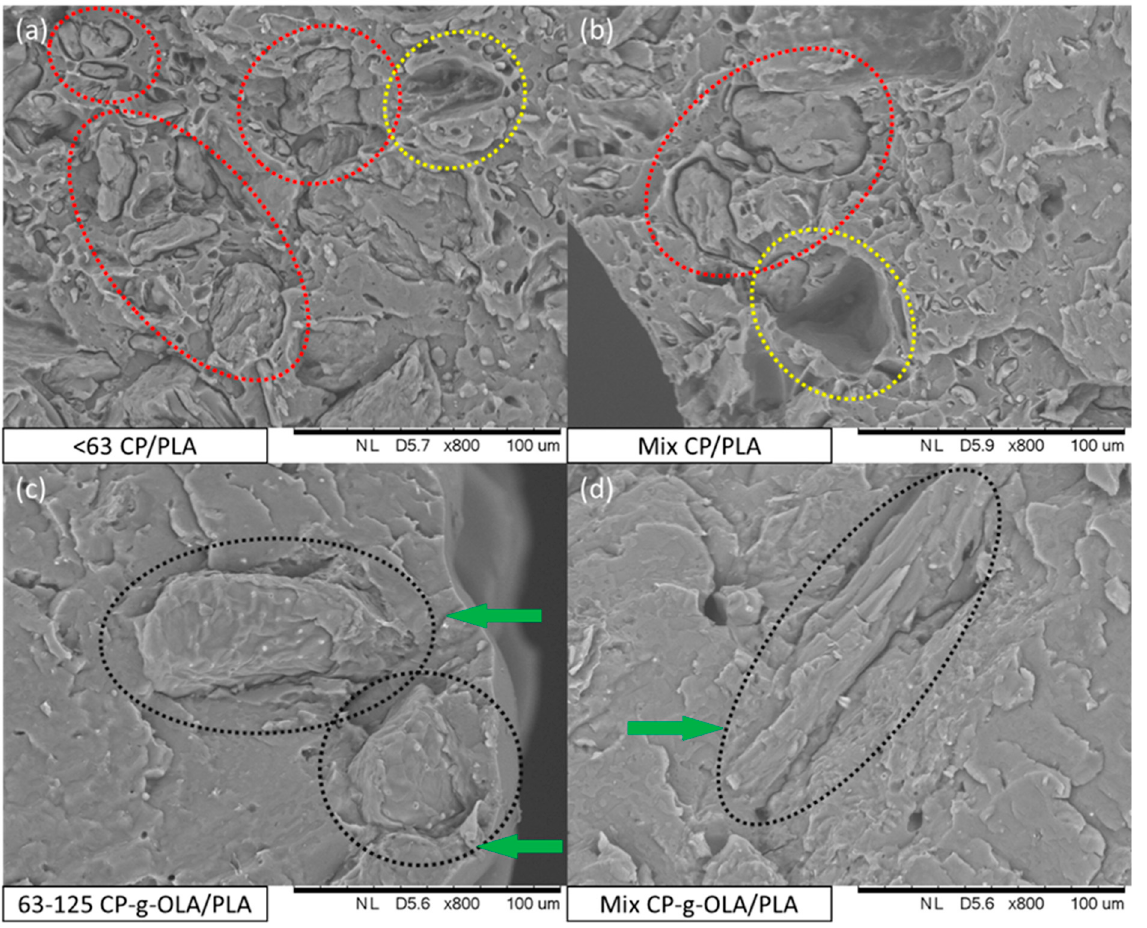
Figure 6. SEM images of ( a ) <63 CP/PLA; ( b ) Mix CP/PLA; ( c ) 63–125 CP-g-OLA/PLA; ( d ) Mix CP-g-OLA/PLA biocomposites.